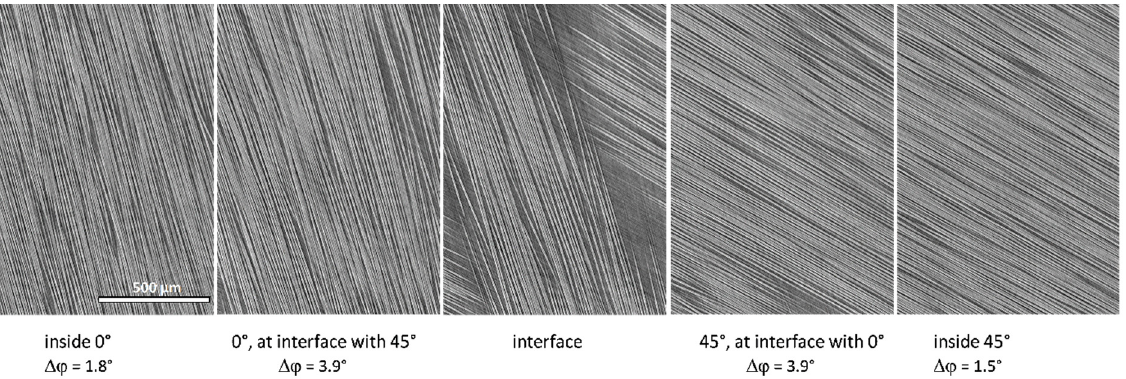
Figure 9. In ‐ plane fiber misalignment over the 0°/45° interface, laminate N111. The images are ro ‐ Figure 9. In-plane fiber misalignment over the 0 ◦ /45 ◦ interface, laminate N111. The images are tated 15° counter ‐ clockwise. The scale is the same for all of the images. rotated 15 ◦ counter-clockwise. The scale is the same for all of the